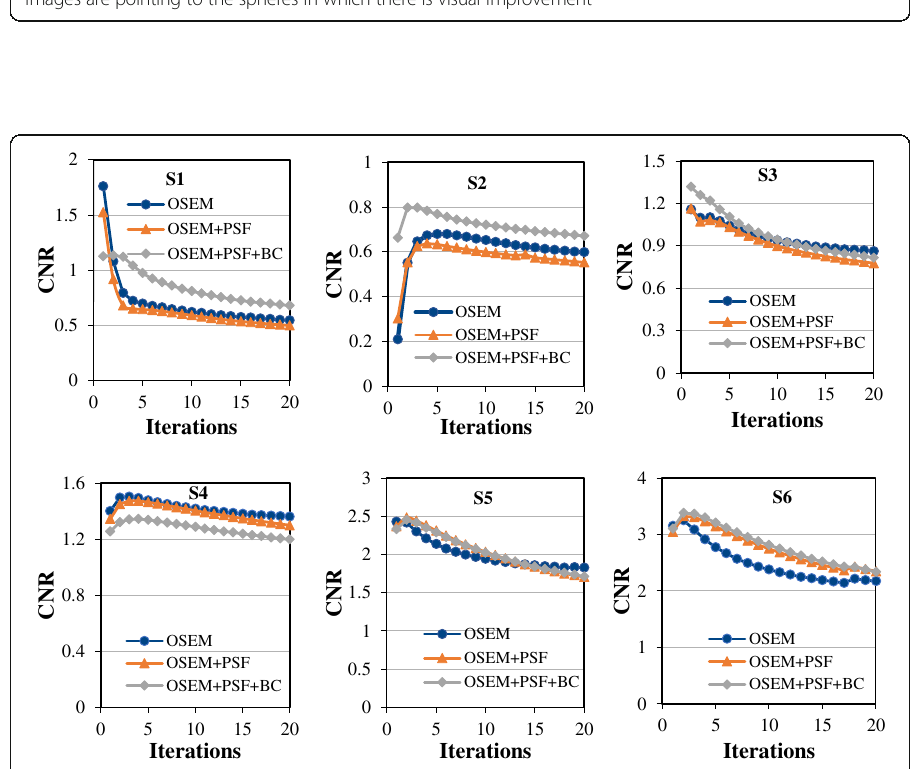
Fig. 10 Plots of the CNR of the NEMA phantom spheres S1 – S6 against the iteration for all the reconstruction techniques across the 20 full iterations and without post-filtering. The CNR was estimated using the mean activity values in the spheres and